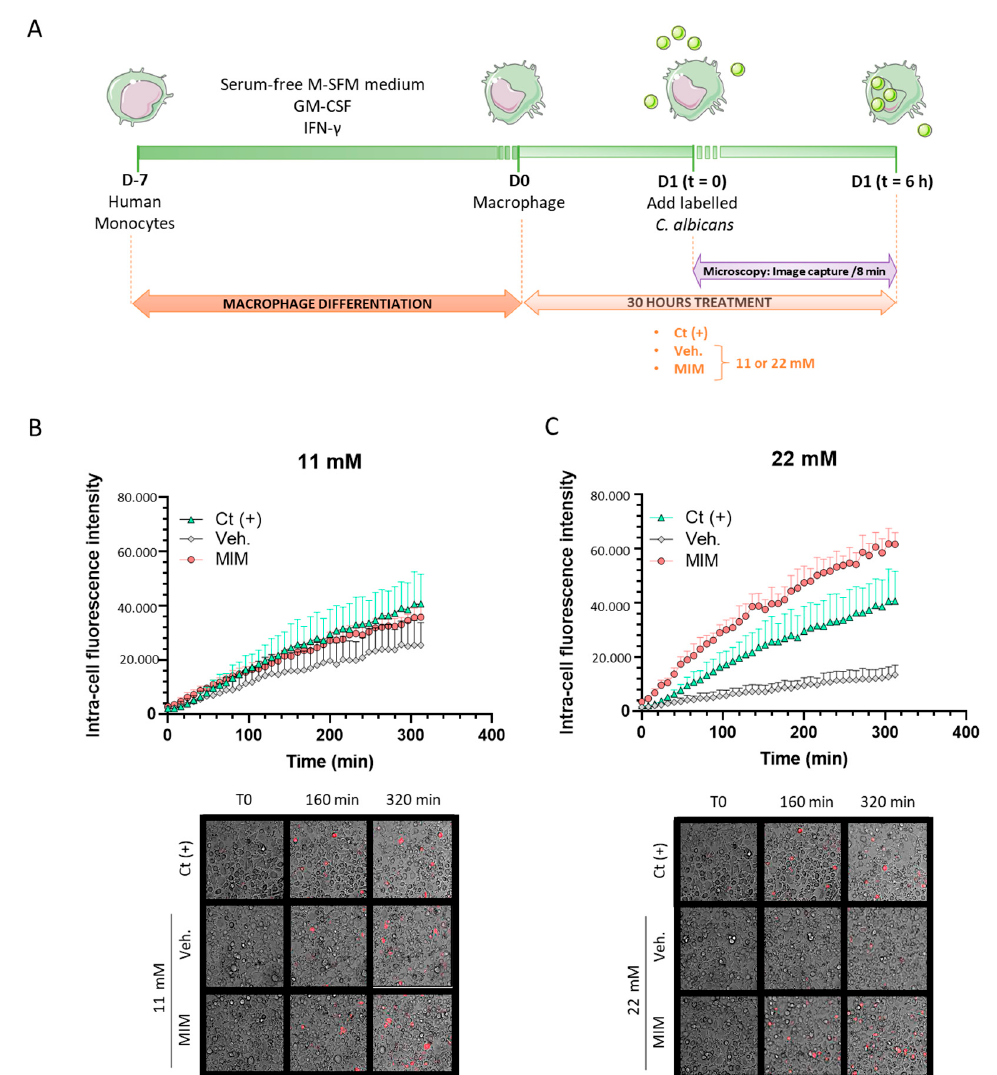
Figure 1. MIM effects on the phagocytosis capabilities of monocyte-derived macrophages. ( A ) Schematic representation of the experimental protocol. ( B , C ) Upper panels : Monocytes isolated from one healthy donor were differentiated into macrophages for 6 days in presence of GM-CSF and IFN- γ . The treatment with MIM or vehicle at either ( B ) 11 mM or ( C ) 22 mM started 24 h before inducing the phagocytosis. Each condition was performed in 6 replicates. Data are represented as mean ± SD. ( B , C ) Lower panels : Representative pictures of the wells at different time points. Macrophages are visualized in bright light and phagocytosed C. albicans correspond to the red spots.